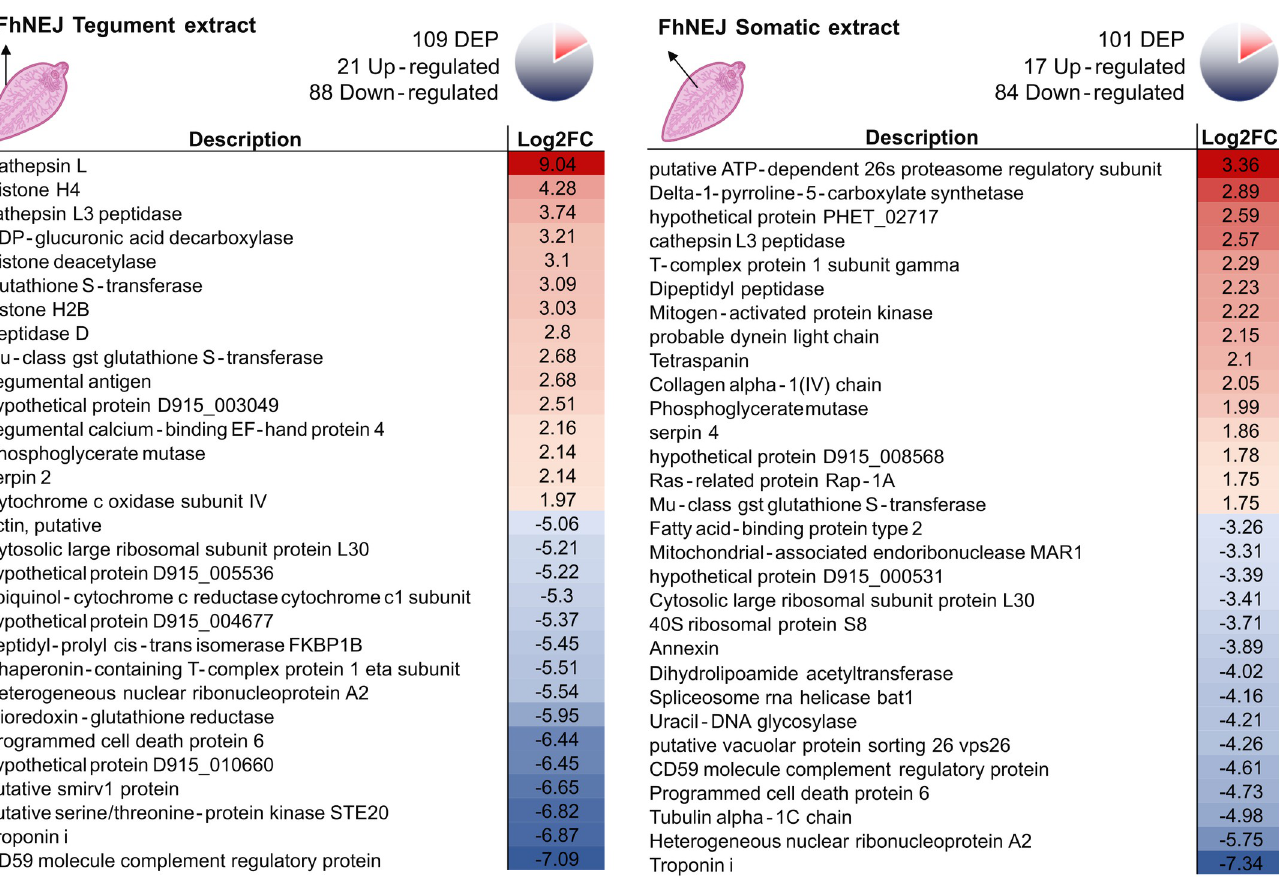
Fig 4. Differentially expressed proteins in FhNEJ after incubation with MPSIEC. The first 15 proteins with the highest (represented in red) or lowest (represented in blue) fold change within the FhNEJ detergent-soluble extract enriched with tegument (FhNEJ Tegument extract) and somatic extract (FhNEJ Somatic extract) are shown. Icons created with